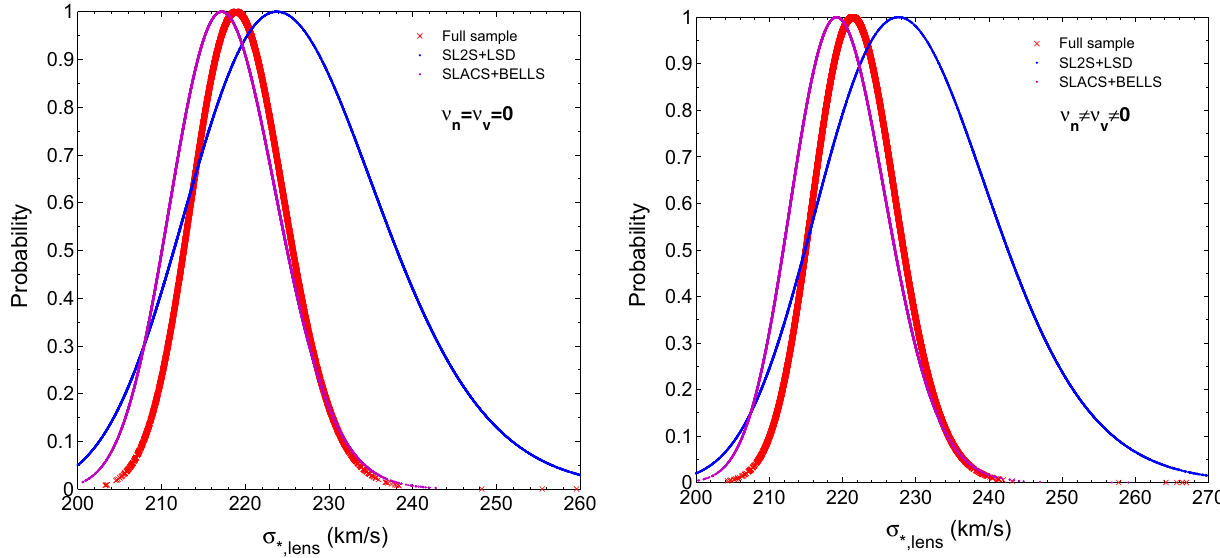
Fig. 6 Confidence limits on the lensing based characteristic velocity dispersion of early-type